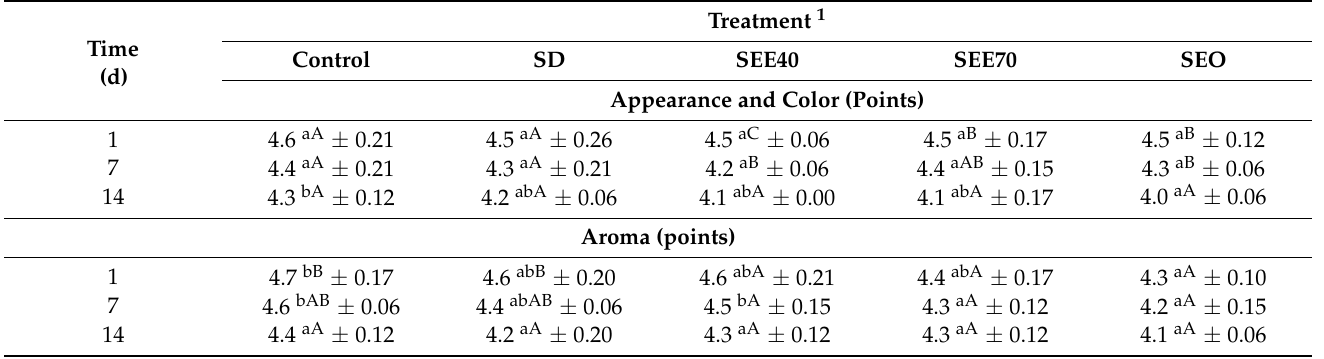
Table 4. Changes in selected organoleptic attributes of chicken meatballs containing MSM from chickens during refrigerated storage (mean value ± standard deviation; n =